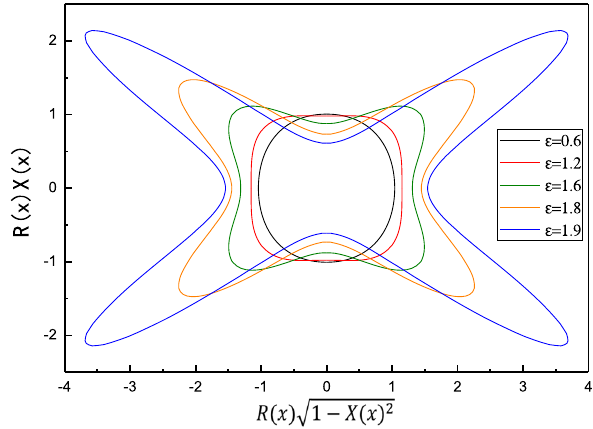
Fig. 3 Hyperbolic embedding of the cross section of the large black hole horizon for different values of ε with T = 0 . 42 and q = 0 .